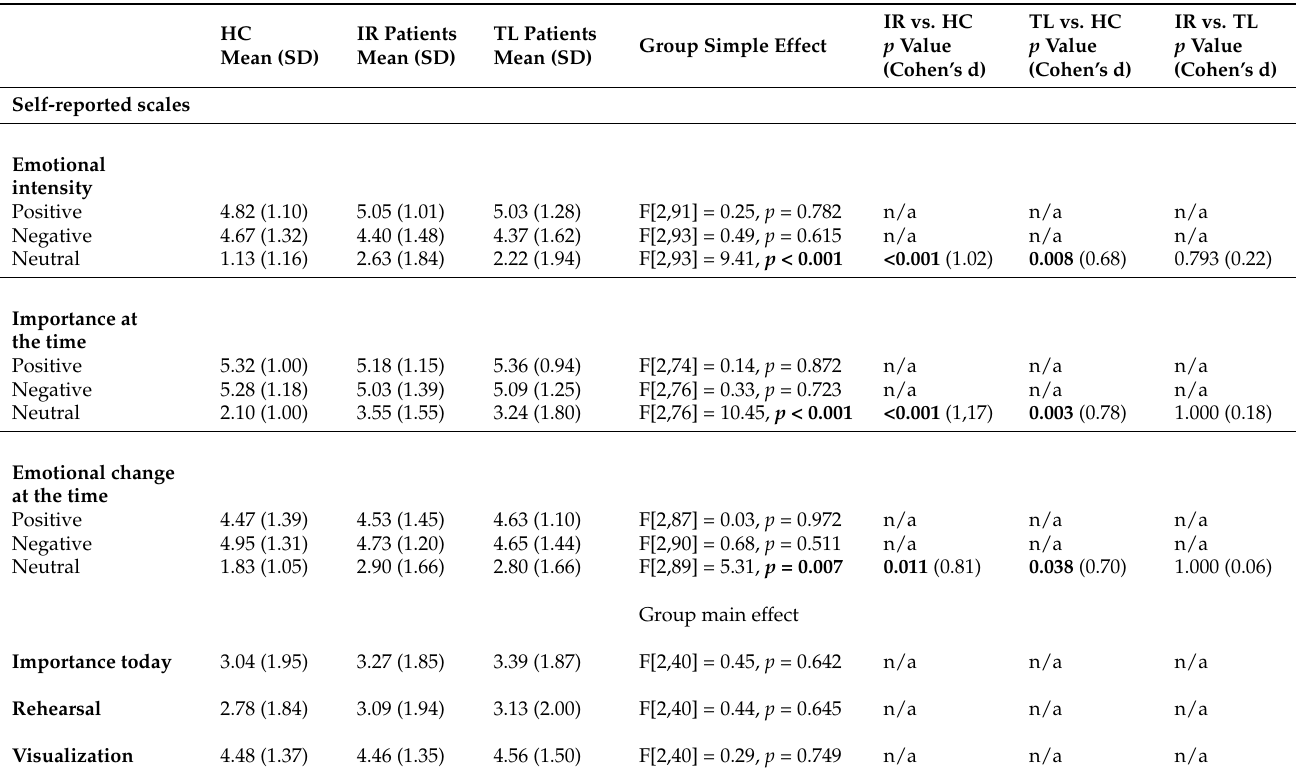
Table 7. Subjective self-reported